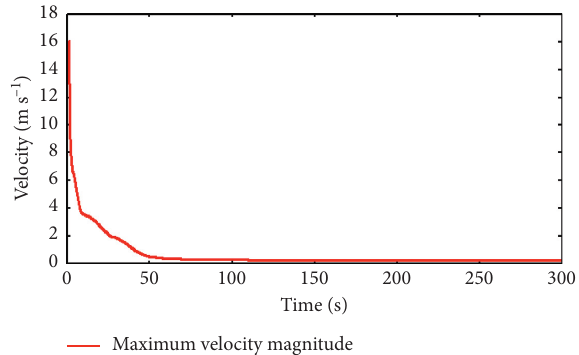
Figure 12: Velocity profile inside the combustion